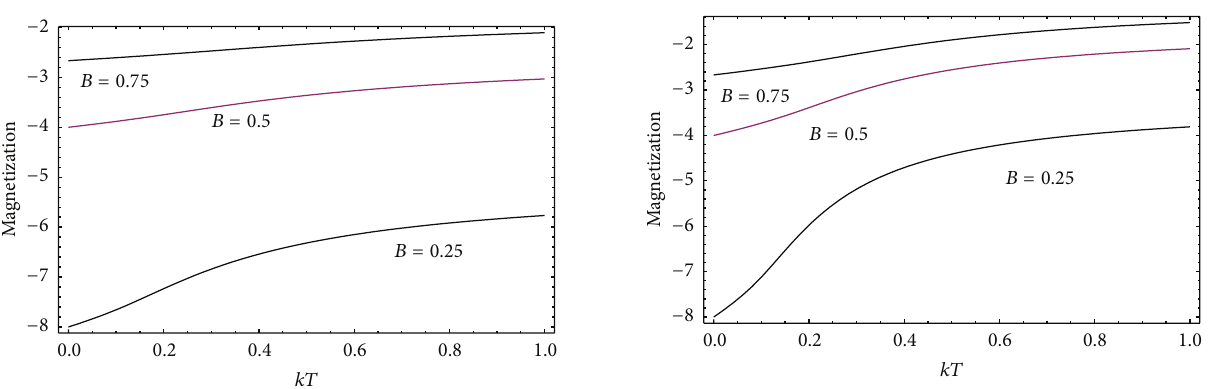
Figure 3: In this case, both dipole and quadrupole excitations are consideredandmagneticsusceptibilitycurvealongeasyaxes (𝜑 = 0) and along hard axes (𝜑 = 𝜋/2)